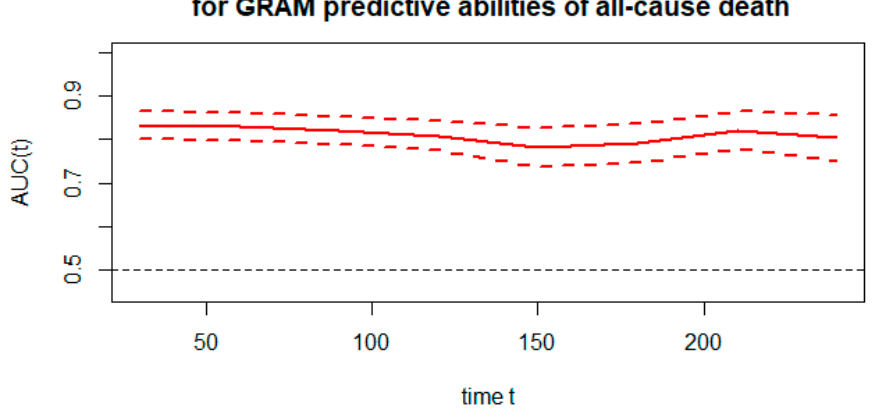
Figure 3. Plot of predictive abilities expressed as area under the ROC curve versus time (in days), along with confidence intervals for this area.